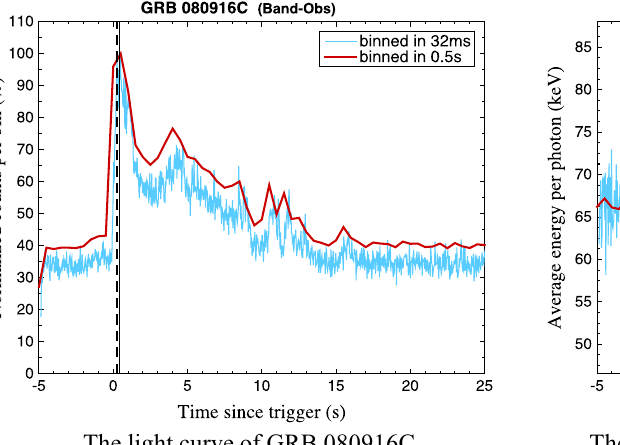
light curve) and the vertical dashed lines refer to t obs /( 1 + z ) chosen by Criterion 2 (the significant peak of the average energy